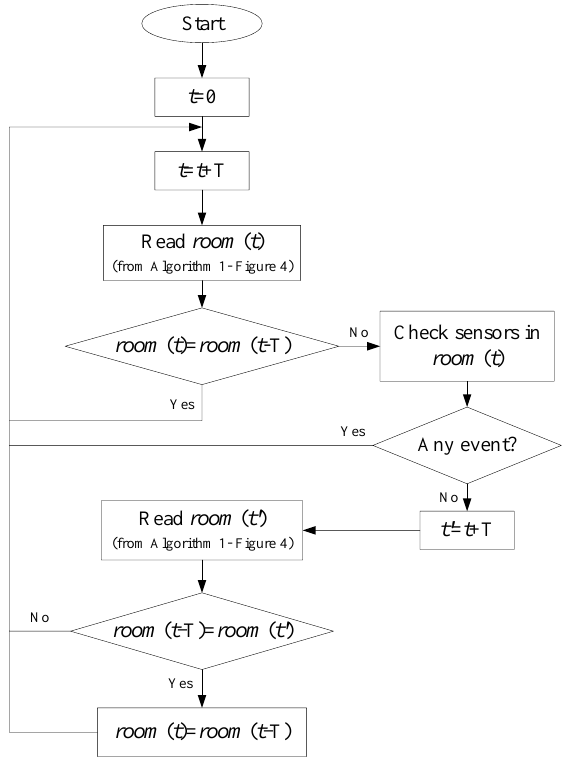
Figure 9. Flowchart of room-level localization in smart homes using BLE data and the activity sensor (Algorithm 2). Table 5. Results of two algorithms ( T A = 1 s; E = −4 dB; RSSI index = m - RSSI index). Time Step